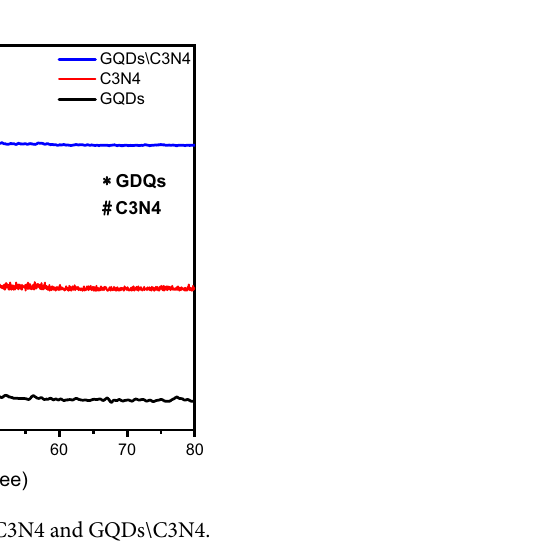
Figure 6. Mapping molecular electrostatic potential at B3LYP/LANL2DZ for the g-C3N4/GQDs.3COOH after interaction with 3 water molecules.